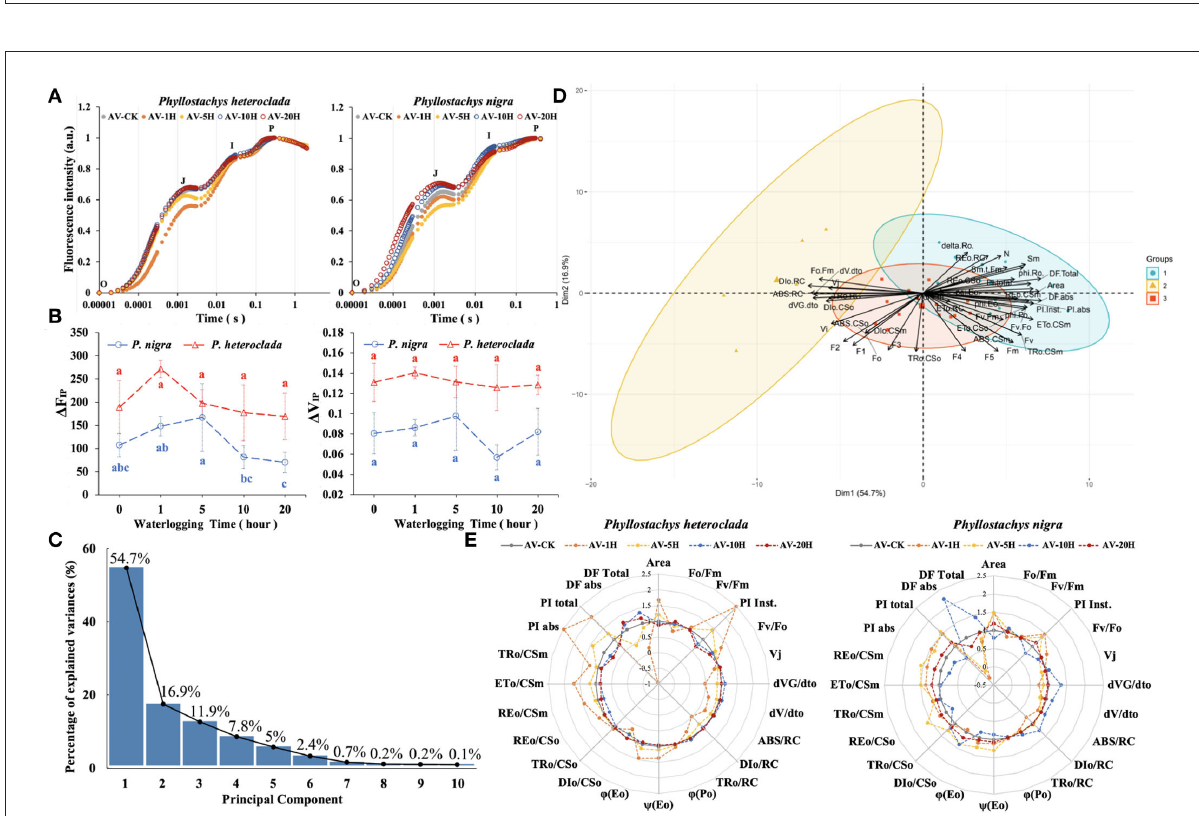
FIGURE6 Effects of waterlogging treatment on the photosynthetic efficiency of Phyllostachys heteroclada and P. nigra under waterlogging conditions. Comparative analysis of the typical Chl fluorescence induction kinetics OJIP (A) , “O” marking the original point of fluorescence and “P” marking the fluorescence peak; fluorescence IP-amplitude 1 F IP and 1 V IP , Different letters indicate significant differences between treatments (analysis of variance with Duncan’s test, P < 0.05) (B) ; analysis of variance contribution rate of all principal component of JIP-test parameters (C) ; the principal component analysis (PCA) of JIP-test parameters (D) ; a radar plot presentation of some important JIP-test parameters quantifying the behavior of PSII, all values are expressed compared with the values of control (E) . The experiment was performed with at least three